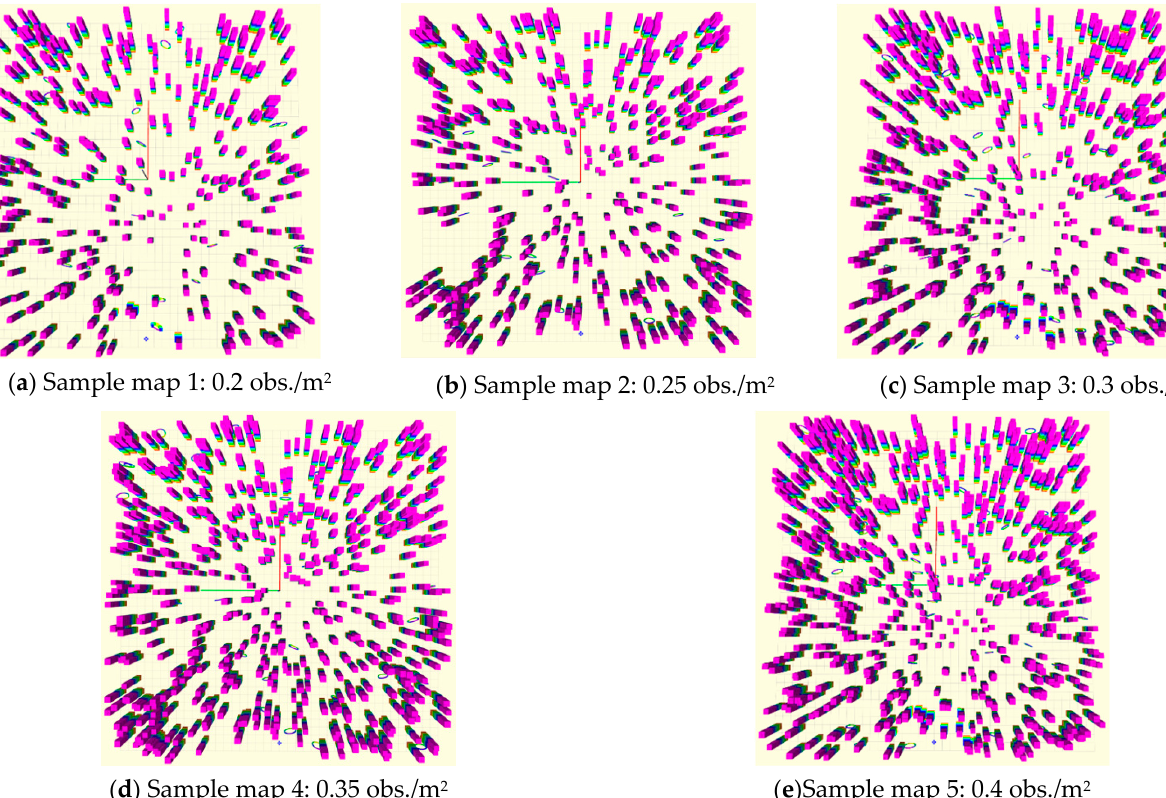
Figure 8. Samples of the maps generated by different obstacle densities.